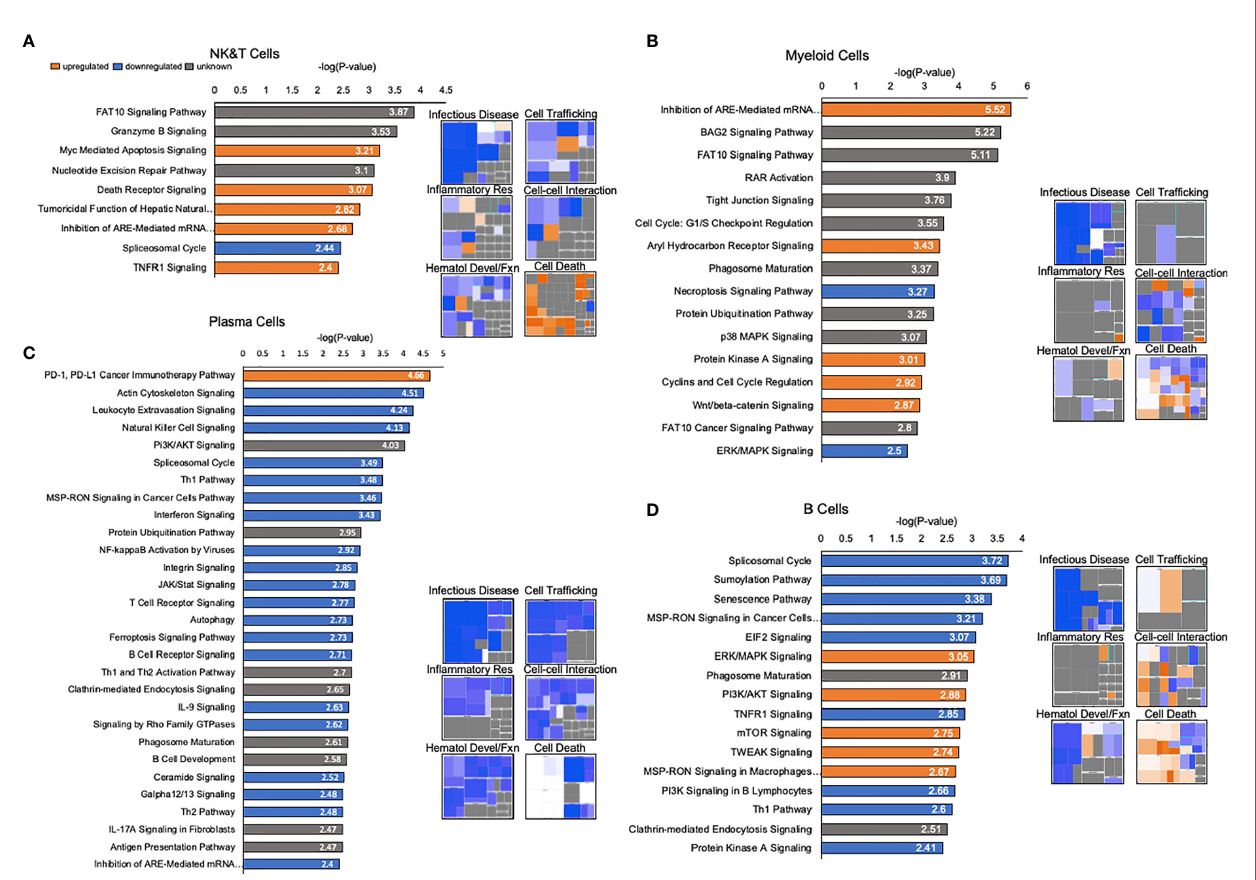
FIGURE 7 | Detailed pathway analysis of human liver immune meta-atlas shows selective upregulation of death-related transcripts and downregulation of immune- related cell functions. (A) Pathway analysis of NK and T cells based on differential expression between human liver meta-atlas versus normal human PBMC. Histograms showing -log(P-value) corresponding to the signi fi cance of the involved signaling pathway. Orange corresponds to upregulated pathways, blue shows downregulated pathways and gray corresponds to unknown directionality based on Ingenuity Knowledge Base. Heatmaps showing perturbations in speci fi c functions of NK and T cells in the human liver relative to PBMC. (B) Myeloid Cell pathway analysis showing canonical pathway functioning in human liver relative to human PBMCs. Heatmaps of speci fi c functions within Myeloid cells relative to PBMCs. (C) Canonical pathway functioning Plasma Cells of the human liver relative to PBMC with associated heatmap of speci fi c functions. (D) B Cell pathway analysis with histograms showing canonical pathways and heatmaps highlighting speci fi c cellular functions in liver relative to